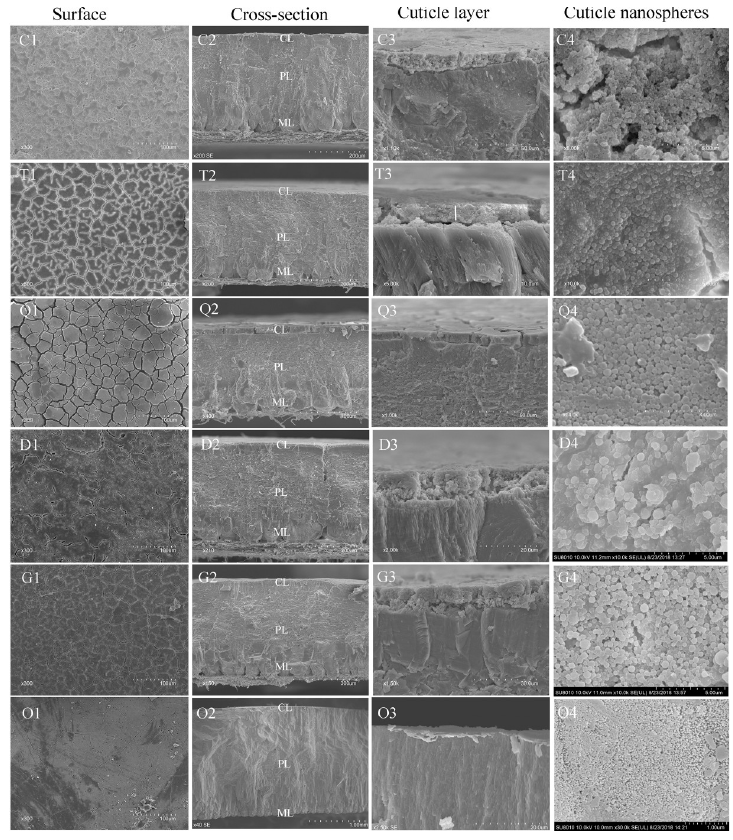
Fig 1. Scanning electron micrographs showing eggshell surface, cross-section, cuticle layer, and cuticle nanospheres of chicken (C), turkey (T), quail (Q), duck (D), goose (G), and ostrich (O). Cross-sections revealed that the shell was divided into a mammillary layer (ML), palisade layer (PL), and cuticle layer (CL).